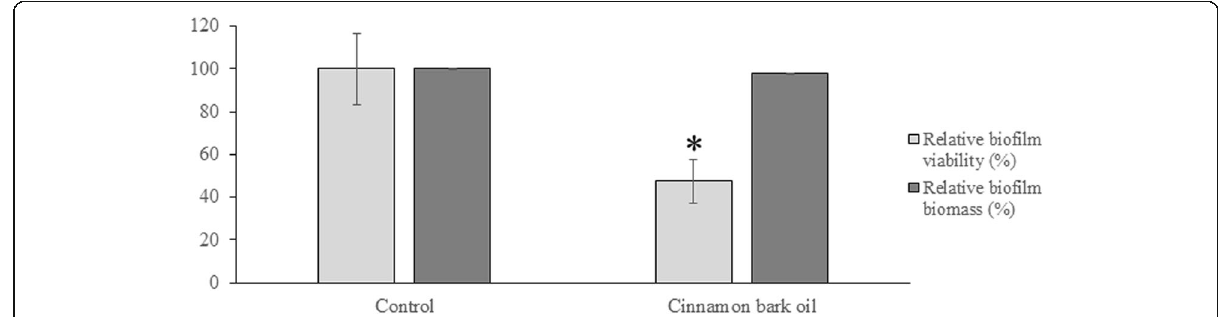
Fig. 4 Effect of cinnamon bark oil on the viability and desorption of a C. albicans ATCC 28366 biofilm. A pre-formed (24 h) C. albicans biofilm was treated for 60 min with cinnamon oil at its MFC, and the residual biomass and viability were measured by crystal violet staining and an XTT assay, respectively. A value of 100% was assigned to the pre-formed biofilm exposed to the cinnamon oil carrier solvent. The assays were performed in triplicate, and the mean ± SD of two independent experiments was calculated. *: significantly different from the control ( p <